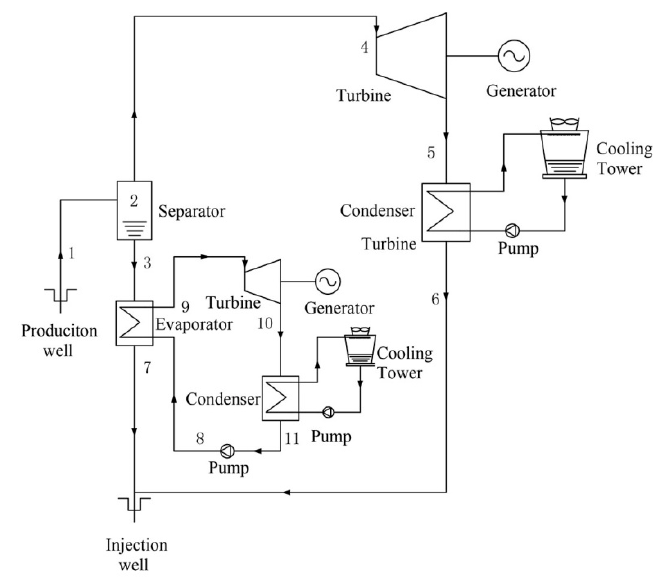
Figure 3. Flash ‐ organic Rankine cycle (FORC) system.